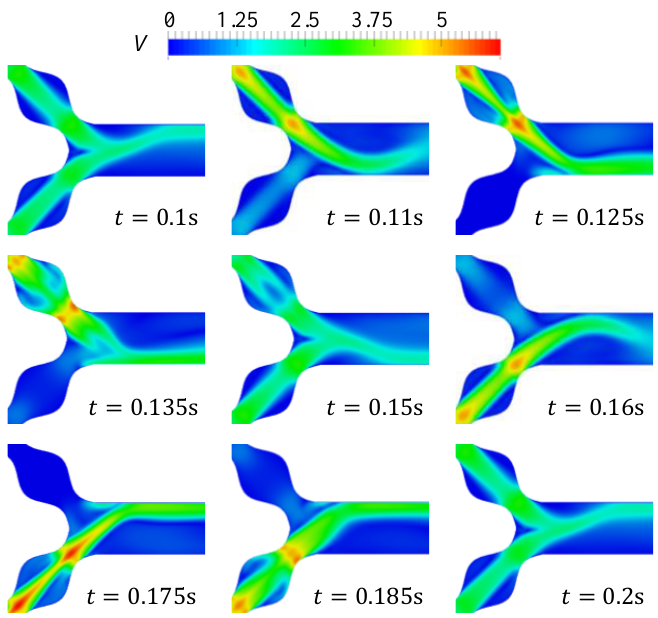
Figure 16. Evolution of the velocity field during one pulse period.